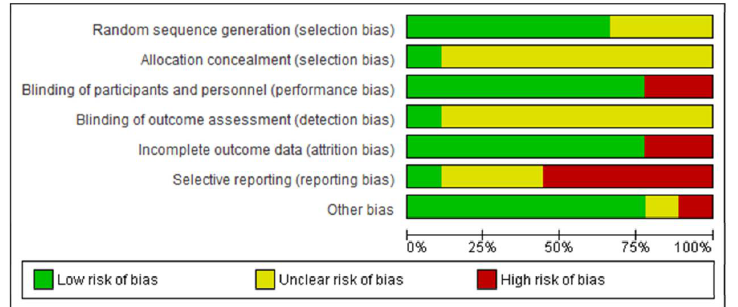
Figure 2. Risk of bias graph: Authors’ judgments about each risk-of-bias item presented as percentages across all included studies.